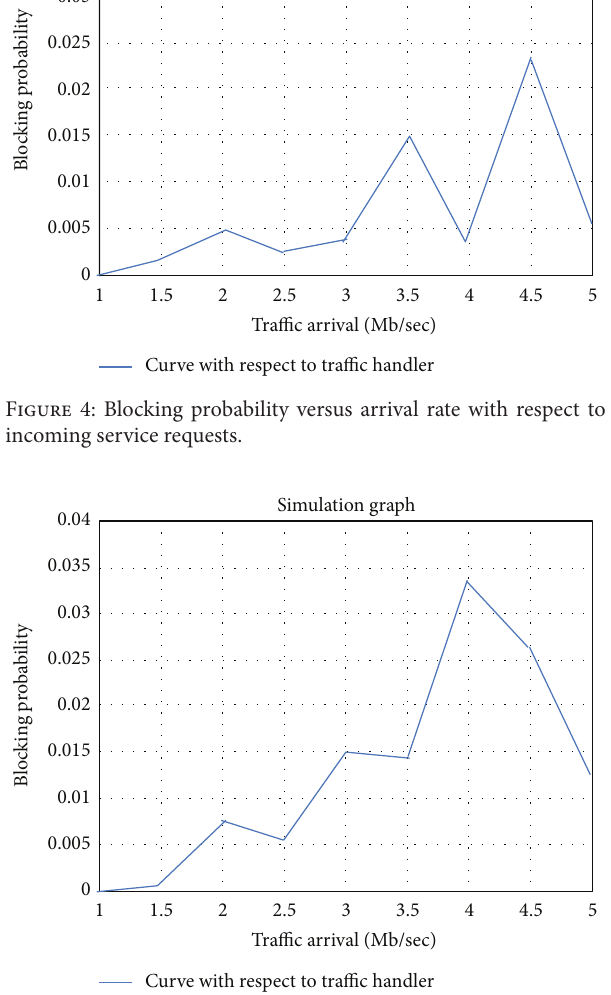
Figure 5: Blocking probability versus arrival rate with respect to the randomly generated probability set.